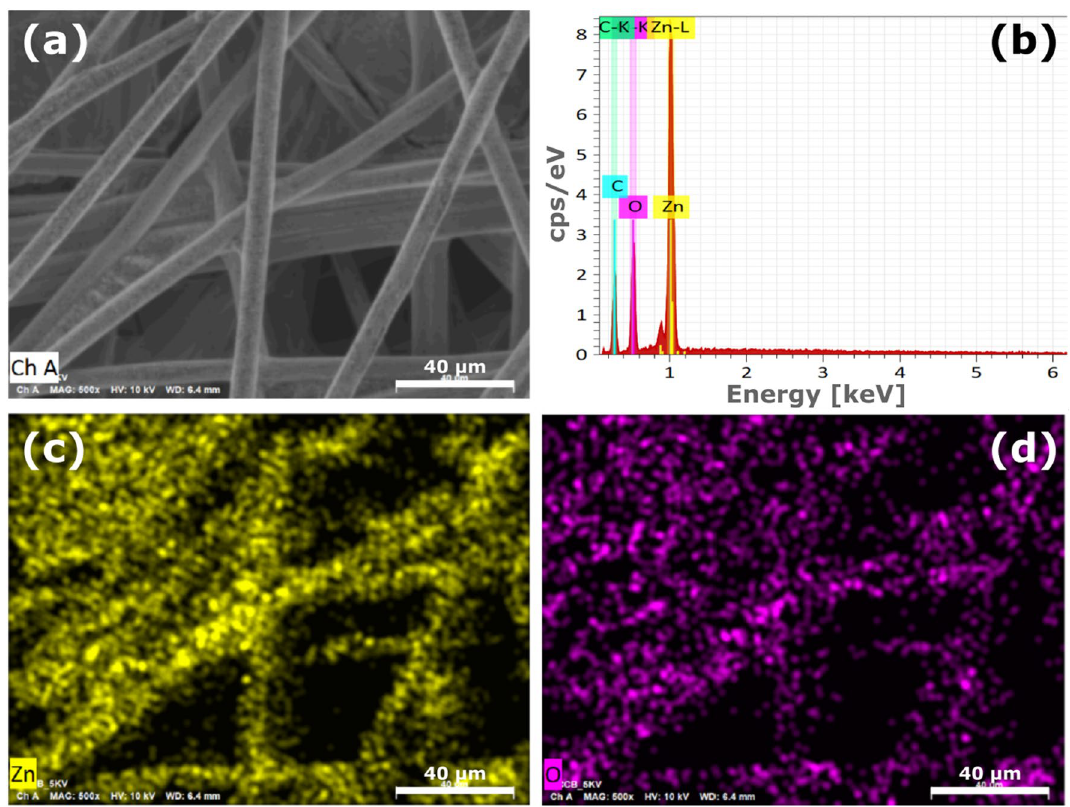
Figure 3. ( a ) SEM image of a typical C-ZnO:Al(NRs) sample with ( b ) corresponding EDS spectra, and spatial EDS mapping of ( c ) Zn and ( d ) O in the same